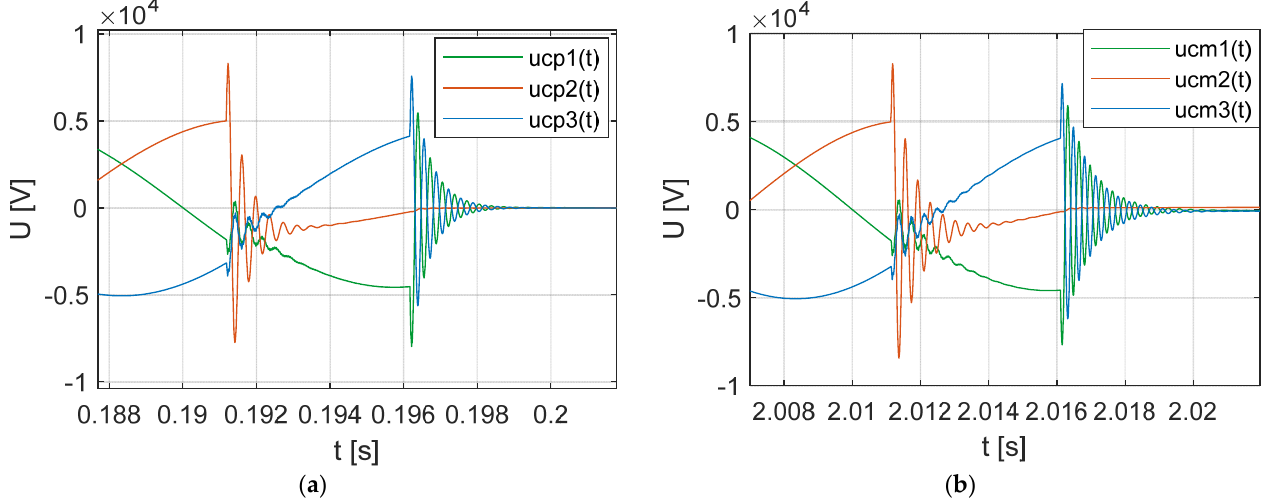
Figure 12. Simulation results— 𝑅 (cid:3008)(cid:3015) = 100 MΩ ( a ) Load voltage (EMTP algorithm); ( b ) Load voltage Figure 12. Simulation results— R GN = 100 M Ω ( a ) Load voltage (EMTP algorithm); ( b ) Load voltage (Clark transformation). Source: own calculations. (Clark transformation). Source: own